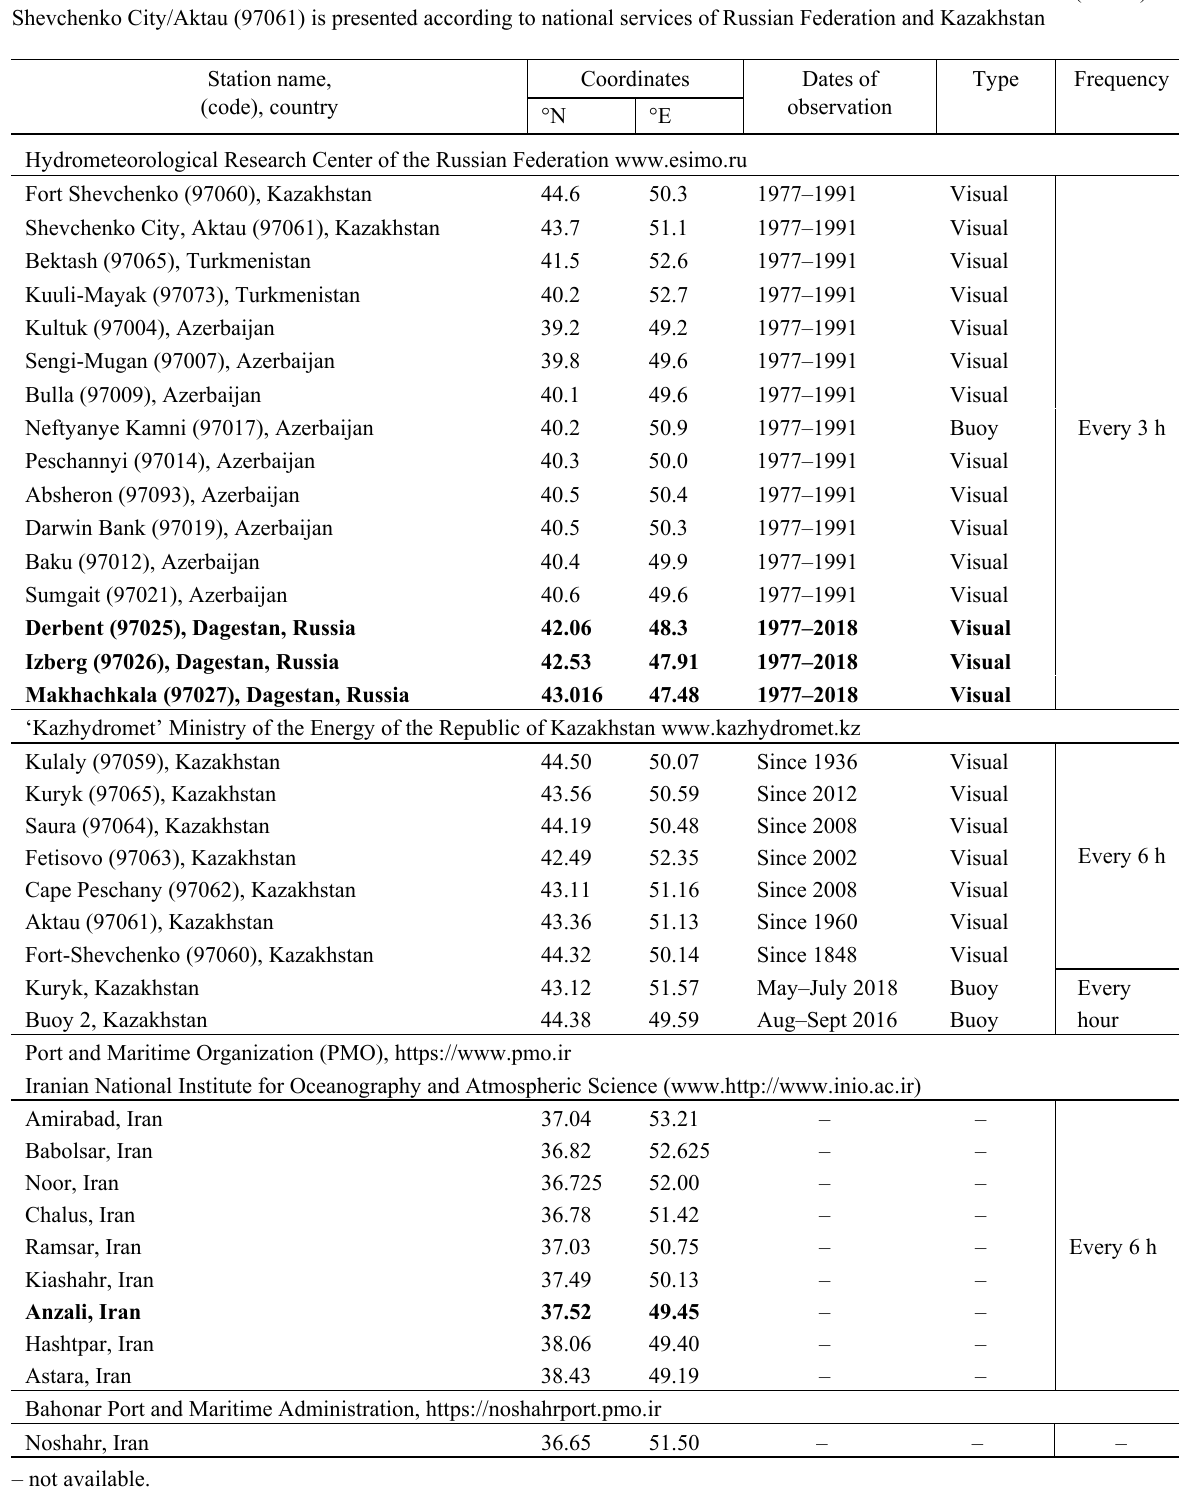
Table 1. Wave height measurement locations and the basic properties of the data sets in the Caspian Sea region. The code in brackets denotes the WMO numeric station code assigned to synoptic weather stations. The first number 9 of the code specifies the Pacific region. Monthly average wave heights for the stations operated by the Hydrometeorological Research Center of the Russian Federation (www.esimo.ru) are publicly available. There is no public access to other data sets. Stations used for the validation of the JASON-1 data are marked in bold. The information for Fort Shevchenko/Fort-Shevchenko (97060) and Shevchenko City/Aktau (97061) is presented according to national services of Russian Federation and